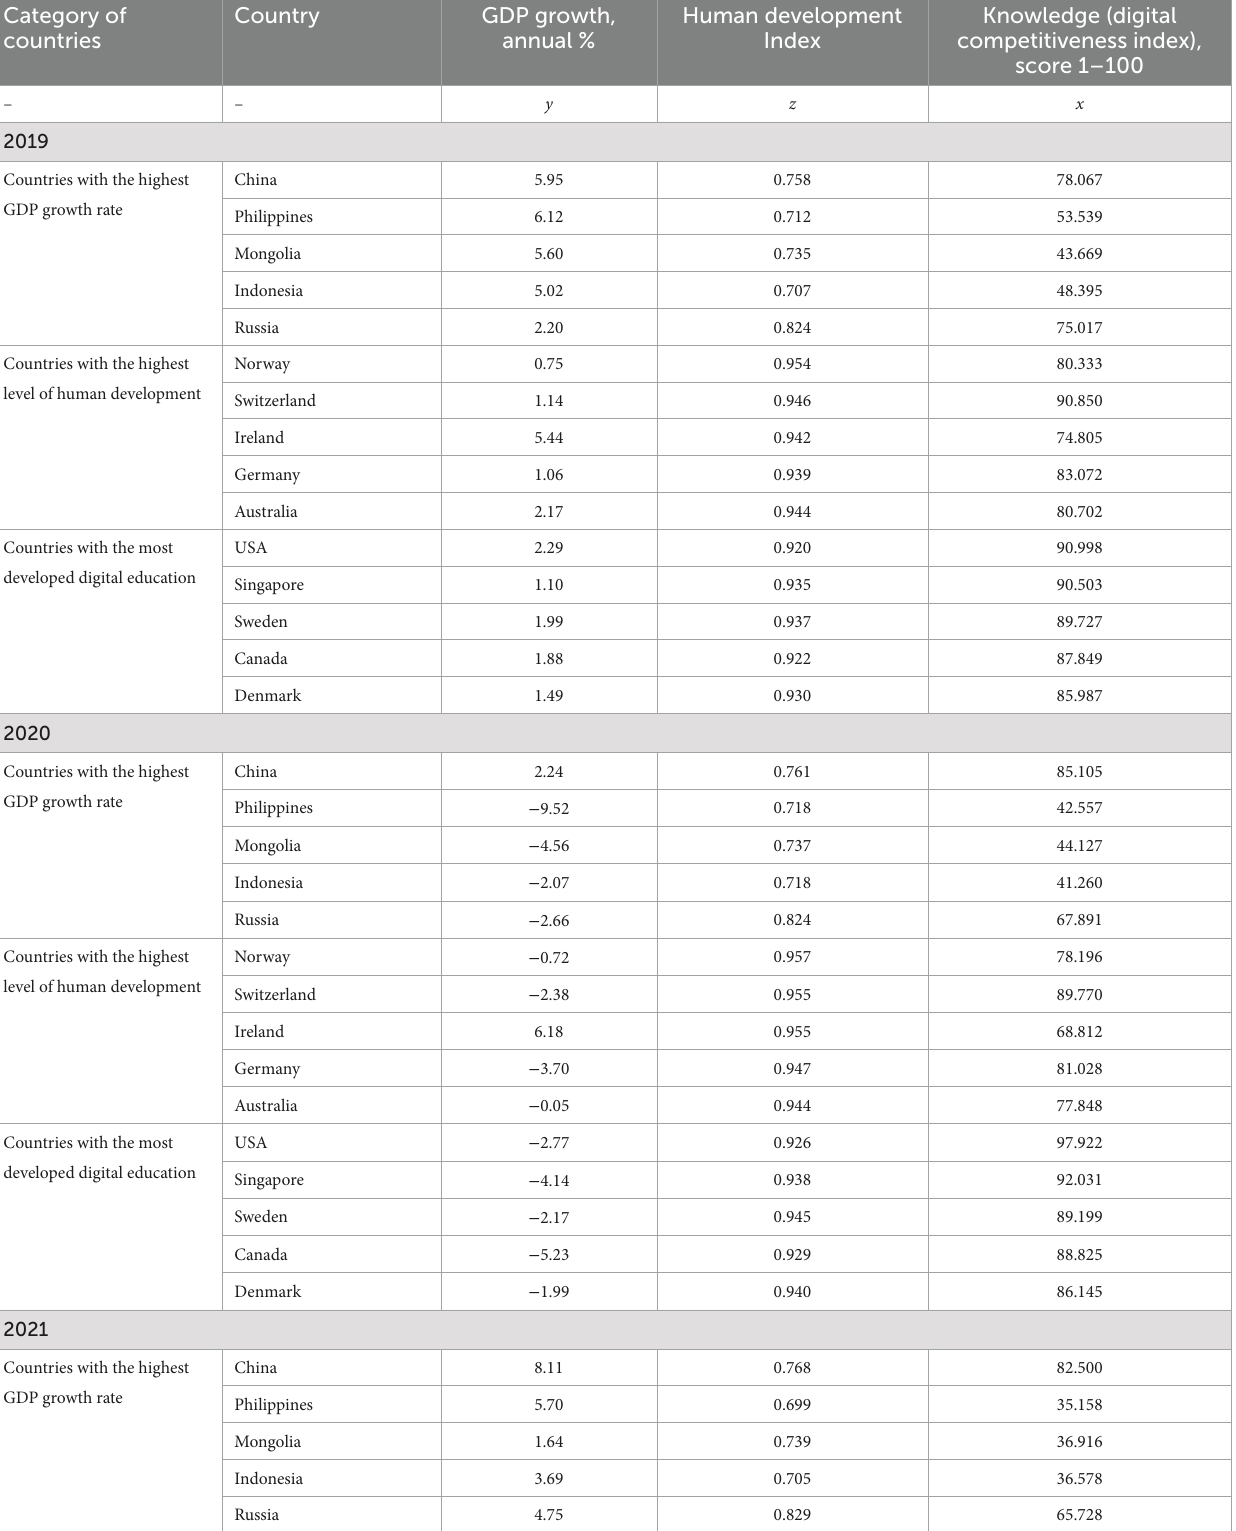
TABLE 1 Statistics of digital education in the social investment model of Gross Domestic Product (GDP) growth in the context of Industry 4.0 in 2019– 2021. Category of countries